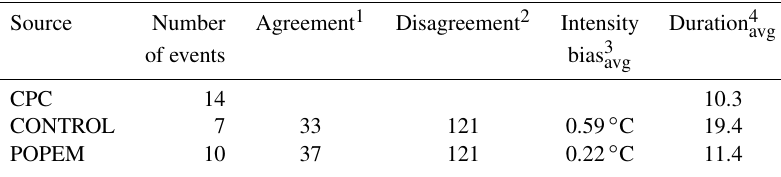
Table 1. Comparison of the ONI index for the period 1950–1999. The table compares the ability of the models to reproduce the number, strength, and duration of El Niño events.